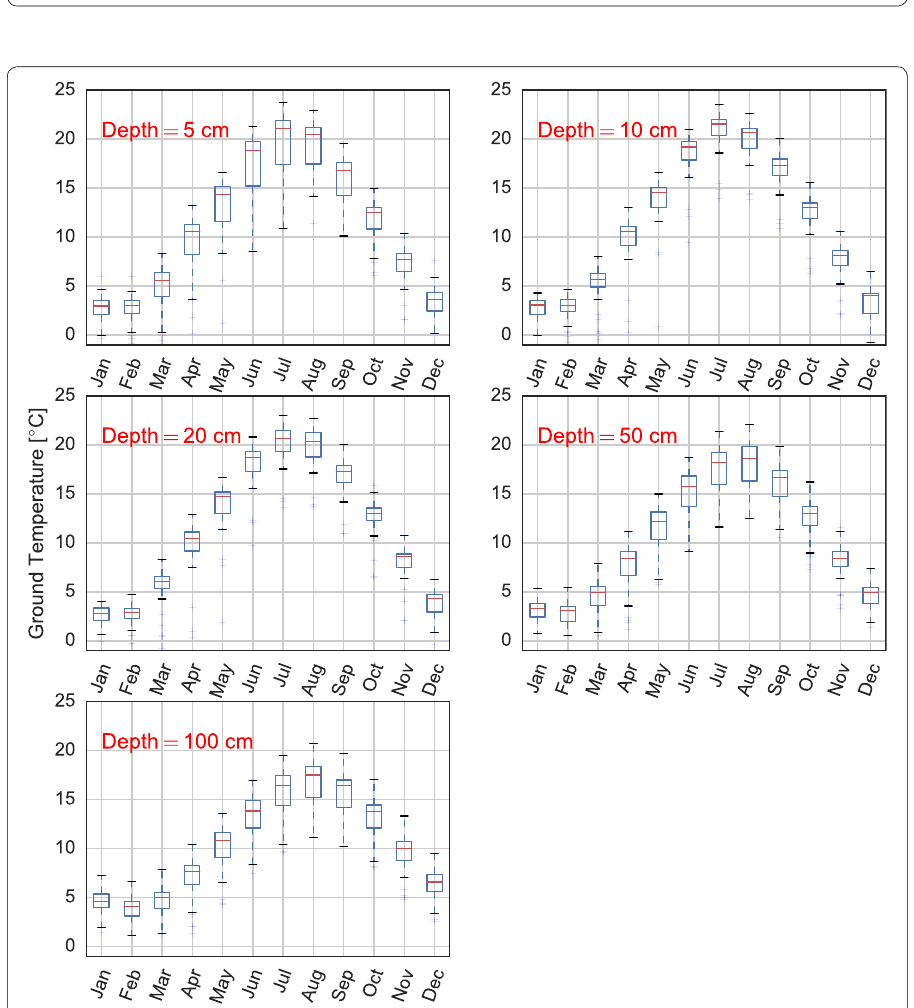
Fig. 5 Box plots for monthly ground temperature data in Switzerland. Box plots are computed over the measurement stations available in Switzerland for each month and shown separately for depths of 5, 10, 20, 50, and 100